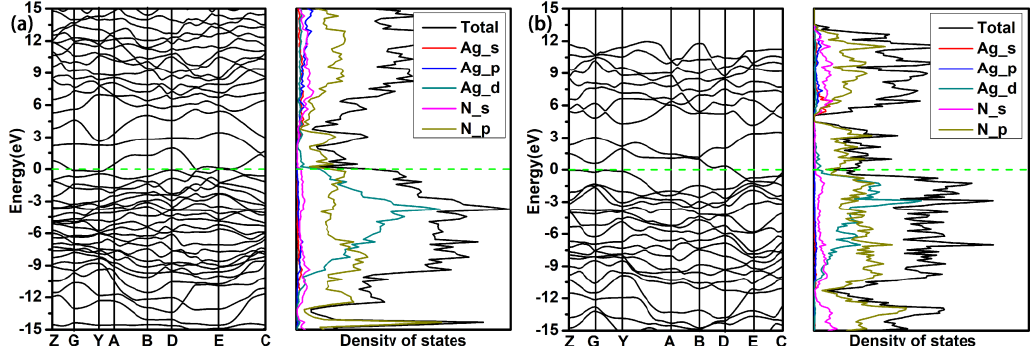
Figure 5. Band structures and projected density of states of P4/mmm-AgN 2 at 100 GPa ( a ), P1-AgN 7 at 50 GPa ( b ), P-1-AgN 7 at 150 GPa ( c ).